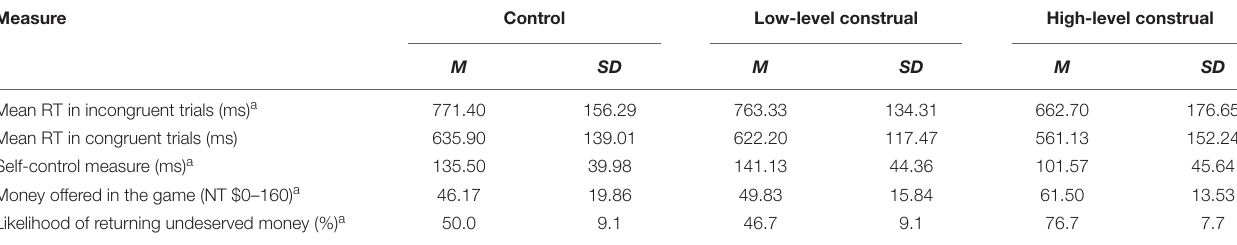
TABLE 2 | State self-control and the tendency toward moral behavior as a function of experimental conditions in Experiment 2. Measure Control Low-level construal